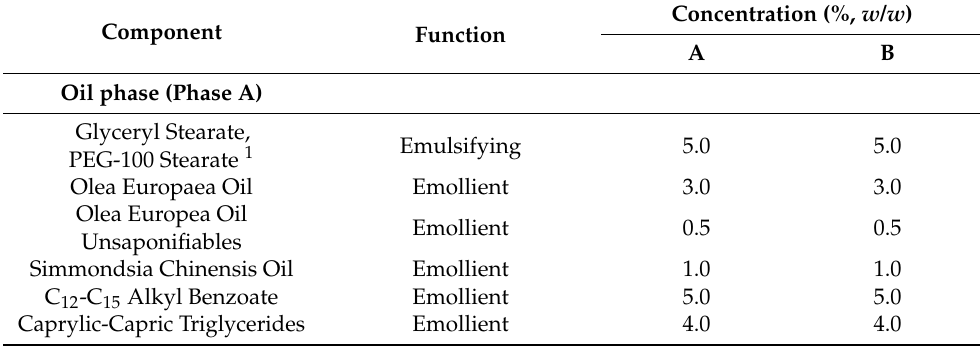
Table 1. Qualitative–quantitative composition of blank (A) and CSE-loaded (B) O/W